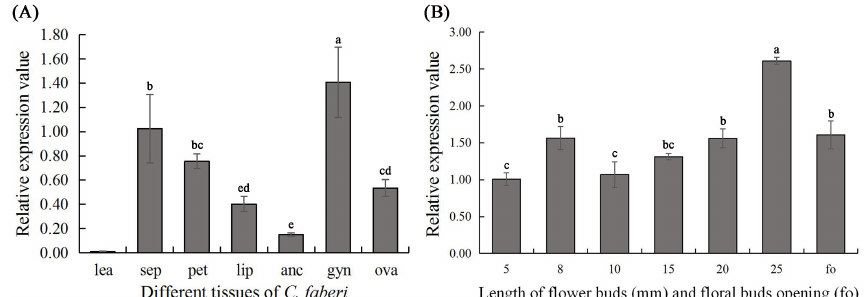
Figure 3. CyfaPI expression was detected by RT-qPCR in different tissues ( A ) and various stages of flower development ( B ) in C. faberi . (A) Expression of CyfaPI in the juvenile leaves (lea), sepals (sep), petals (pet), lips (lip), anther caps (anc), gynostemia (gyn) and ovaries (ova) with the C. faberi ACTIN gene used as the internal control; (B) Expression of CyfaPI at various stages of flower development. Different letters indicate statistically significant